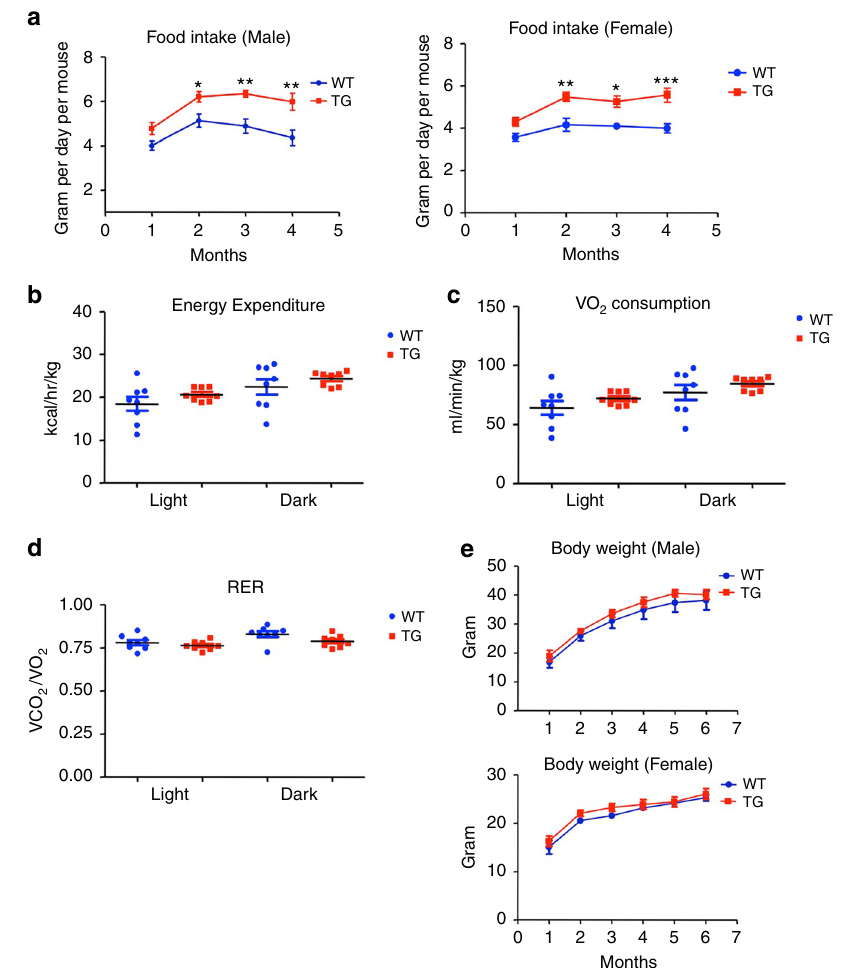
Fig. 3 MANF transgenic mice exhibited increased food intake. a Daily food intake of wild type (WT) and MANF transgenic (TG) mice were measured monthly from 1-month to 4-months of age (* P < 0.05, ** P < 0.01, n = 7 – 8, two-way ANOVA with Bonferroni post-tests, Male, F = 37.8, P < 0.0001; Female, F = 46.95, P < 0.0001). b Energy expenditure of 3-month old WT and TG mice was measured ( n = 8, 2-tailed student t test, Light, t = 1.226, P = 0.2261; Dark, t = 1.02, P = 0.3248). c Rate of oxygen consumption of 3-month old WT and TG mice was measured ( n = 8, 2-tailed student t test, Light, t = 1.256, P = 0.2295; Dark, t = 1.104, P = 0.288). d Respiratory exchange ratio of 3-month old male and female WT and TG mice was measured ( n = 8, 2-tailed student t test, Light, t = 0.9832, P = 0.3422; Dark, t = 2.001, P = 0.0651). e Starting from the age of 6 weeks, TG mice were pair-fed to WT littermates, and the body weights of WT and TG mice were measured monthly from 1-month to 6-months of age ( n = 5, two-way ANOVA with Bonferroni post-tests, Male, F = 3.558, P = 0.9994; Female, F = 4.225, P = 0.9604). Data are represented as mean ±